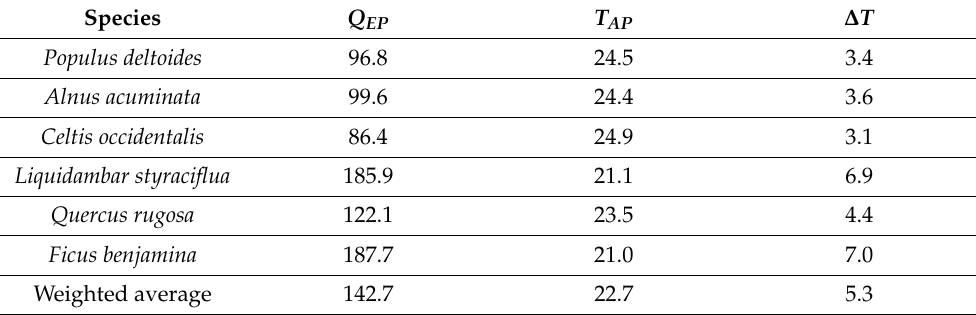
Figure 4. Realistic ambience of the B-B’ profile on Fig ure 3 of the proposed urban park design of a tree community during the growth stage ( A , B ) and at full growth ( C , D ) in the wet ( A , C ) and dry ( B , D ) seasons. Table 4. Cooling potential of a proposed urban park design of a tree community of six tree species in a space of 2500 m 2 (50 m × 50 m) in one day and one hour. Values were calculated using the TUNEE model with an urban air temperature of 28 ◦ C ( T AU ), net radiation of 680 W m − 2 , energy storage (urban fabric) of 252 W m − 2 , and latent and sensible heat of 94.0 and 392 W m − 2 , respectively. The values of the latent heat flux ( Q EP , W m − 2 ) and the air temperature ( T AP , ◦ C) generated by each of the species, as well as the difference between the urban temperature and that of the park species ( ∆ T = T AP − T AU , ◦ C) are